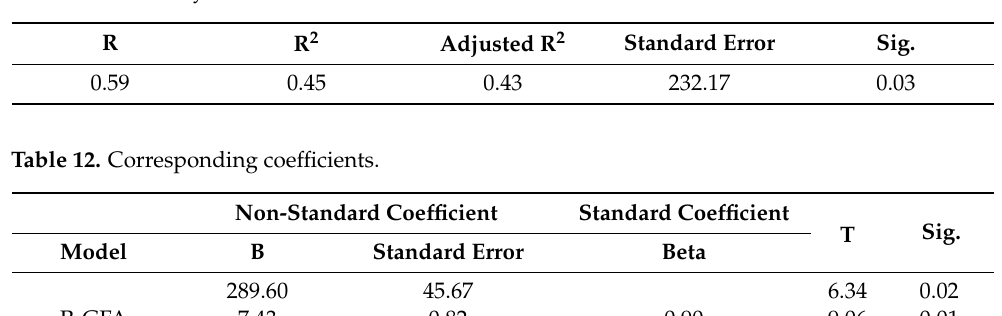
Table 11. Summary of models for residential sites.